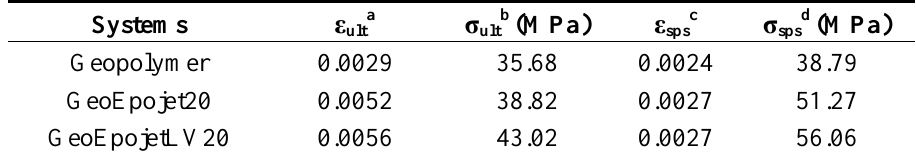
Table 2. Ultimate strain, compressive strength at ultimate strain, strain at peak stress and unconfined compressive strength of the neat geopolymer and of the hybrid composite